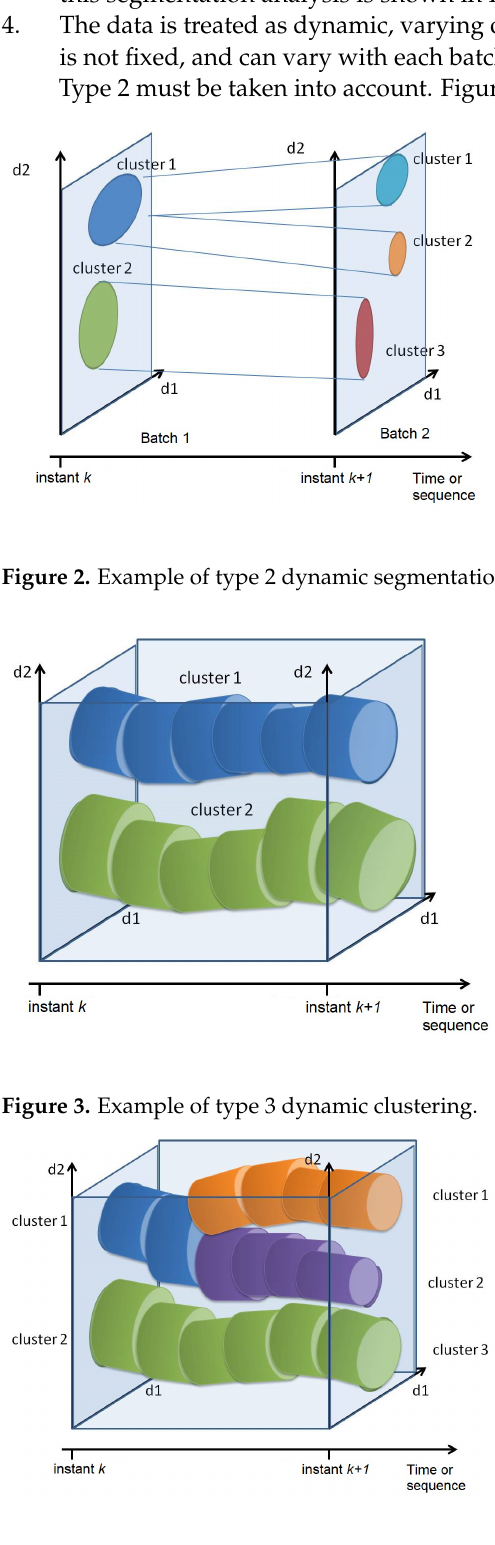
Figure 4. Example of type 4 dynamic